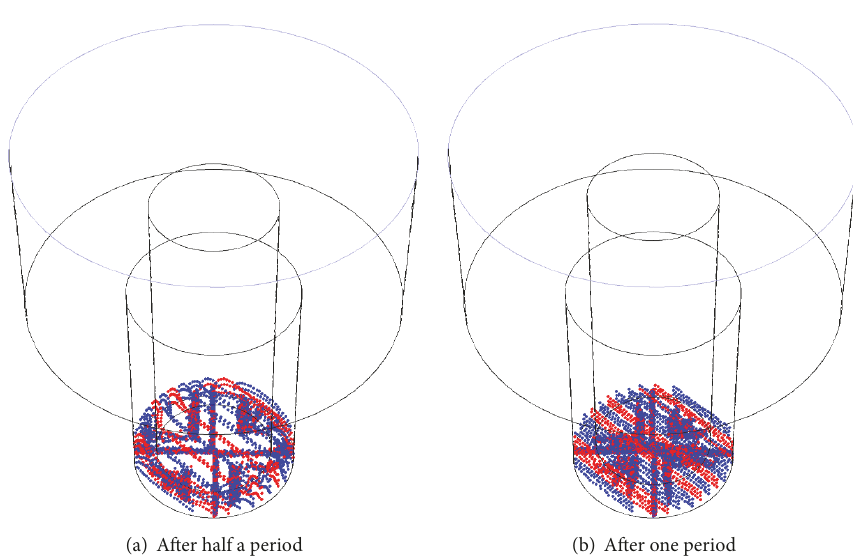
Figure 5: Gap flow field with 2 mm deep hole.